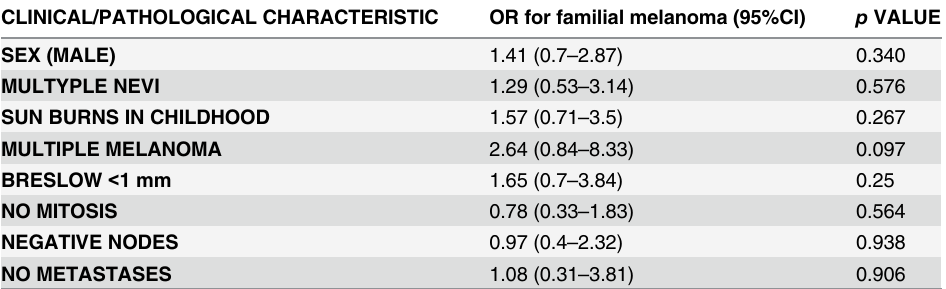
Table 3. Multivariate analysis findings for the association between familial melanoma and variables of interest. CLINICAL/PATHOLOGICAL